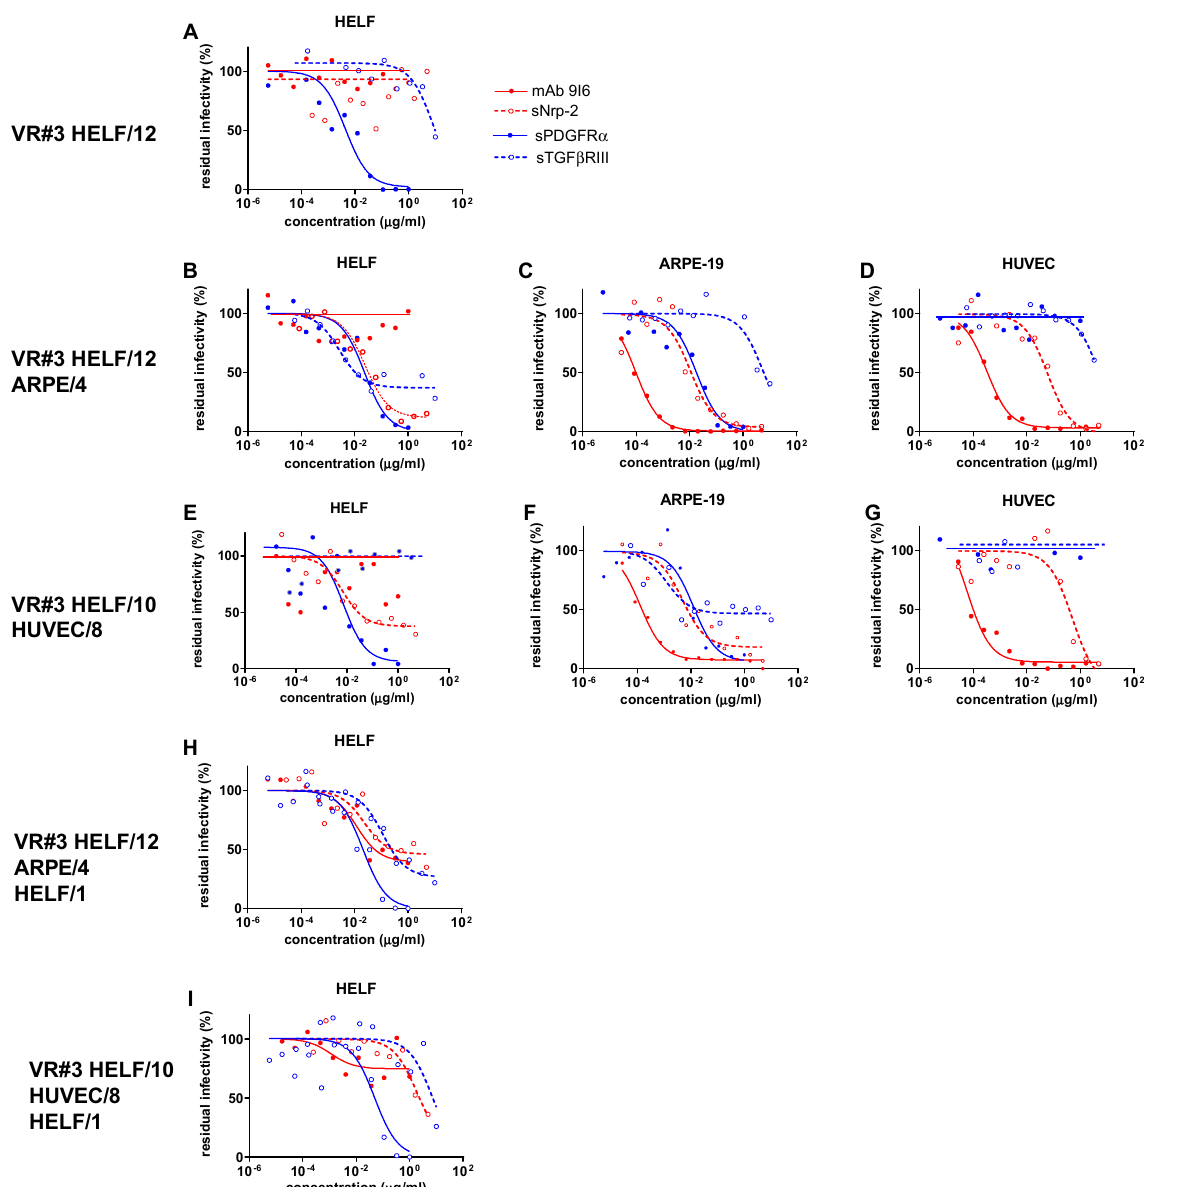
Figure 3. ICs 50 of anti-PC (mAb 9I6, and sNrp-2) and anti-TC (sPDGFR- α , and sTGF β RIII) activity inhibiting infectivity of VR#3, which was recovered and propagated in HELF/12 ( A ), then passaged in ARPE-19/4 ( B – D ) cells, and finally, in HUVEC/8 ( E – G ) primary cells, as determined in HELF ( A , B , E ), ARPE-19 ( C , F ) and HUVEC ( D , G ) cell substrates against residual infectivity. In addition, the inhibiting activities by different agents following back passages of VR#3 from ARPE/4 and HUVEC/8 onto HELF/1 are shown in ( H , I ), respectively.